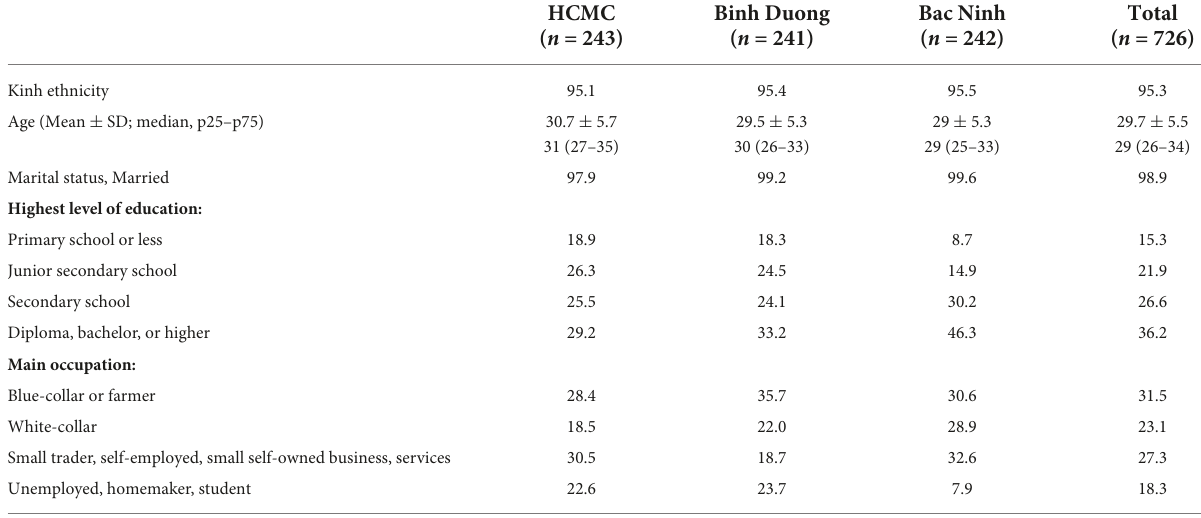
TABLE 1 Socio-economic characteristics of mothers of infants 0–11 months, three provinces, Vietnam 2020 1 .